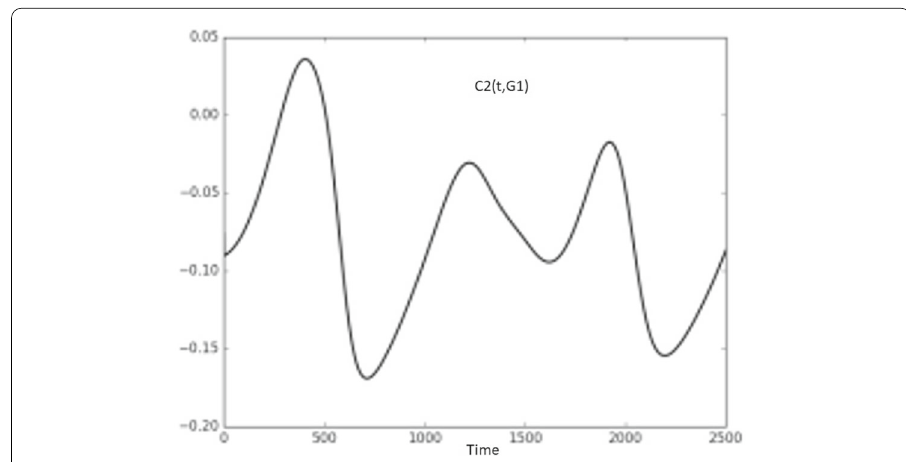
Fig. 30 The second temporal weight by the Galerkin projection upon (cid:9) : c 2 ( t,G 1 )